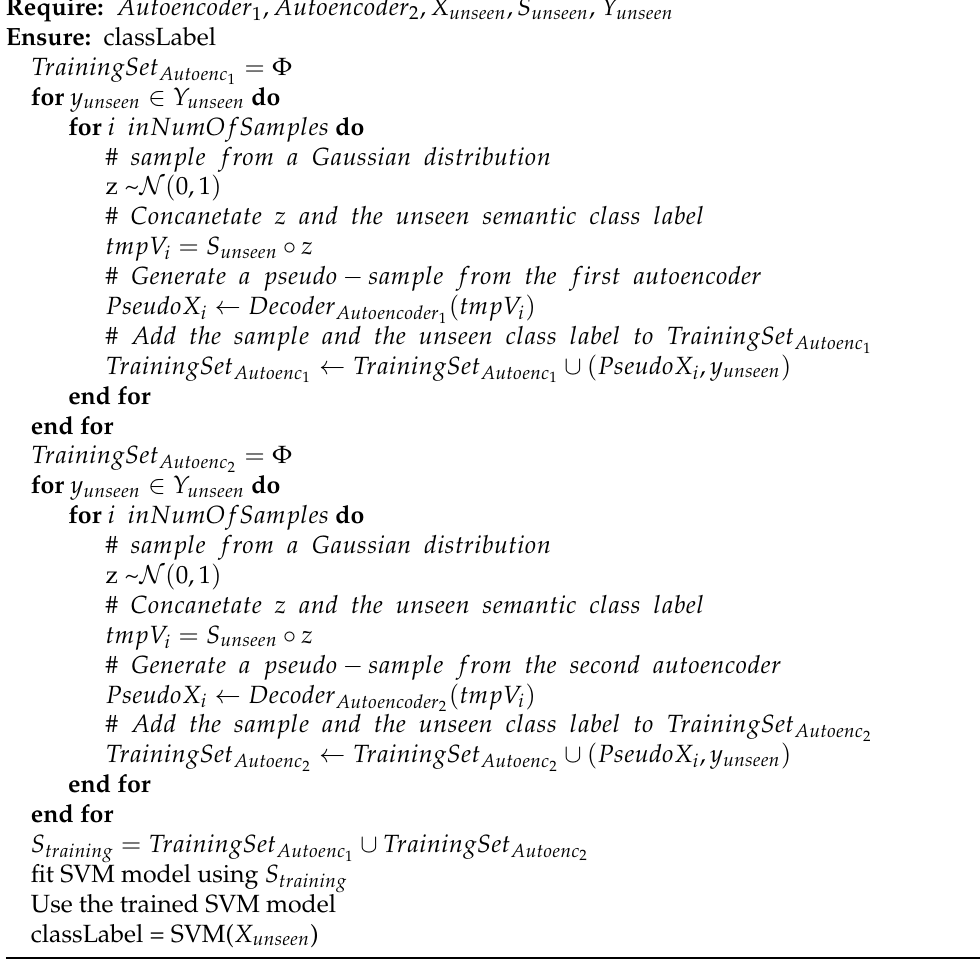
Algorithm 2 Unseen classes classification